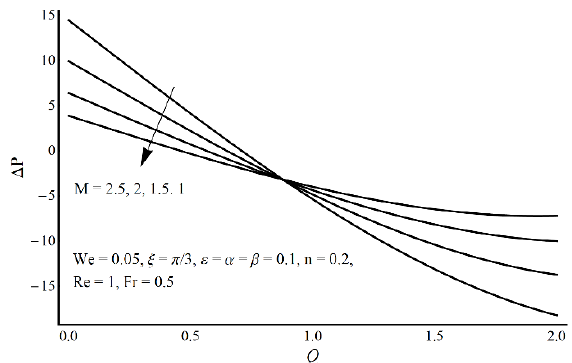
Figure 7. Pressure rise per wavelength at various values of M.